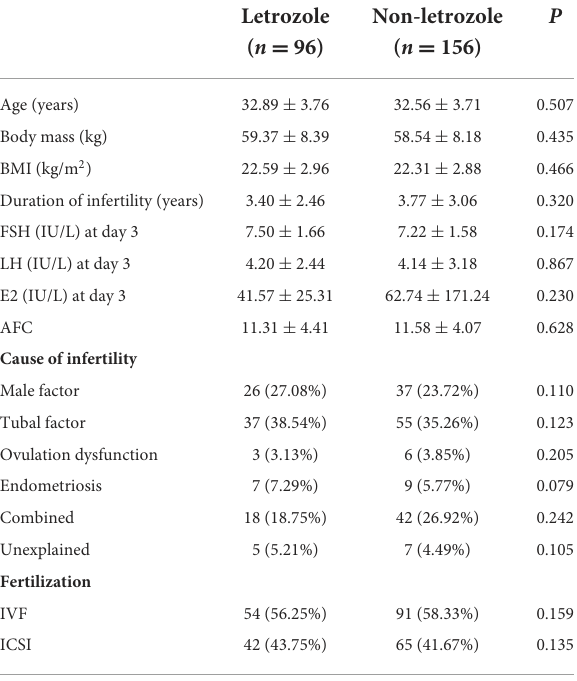
TABLE 1 Baseline patient characteristics for the two